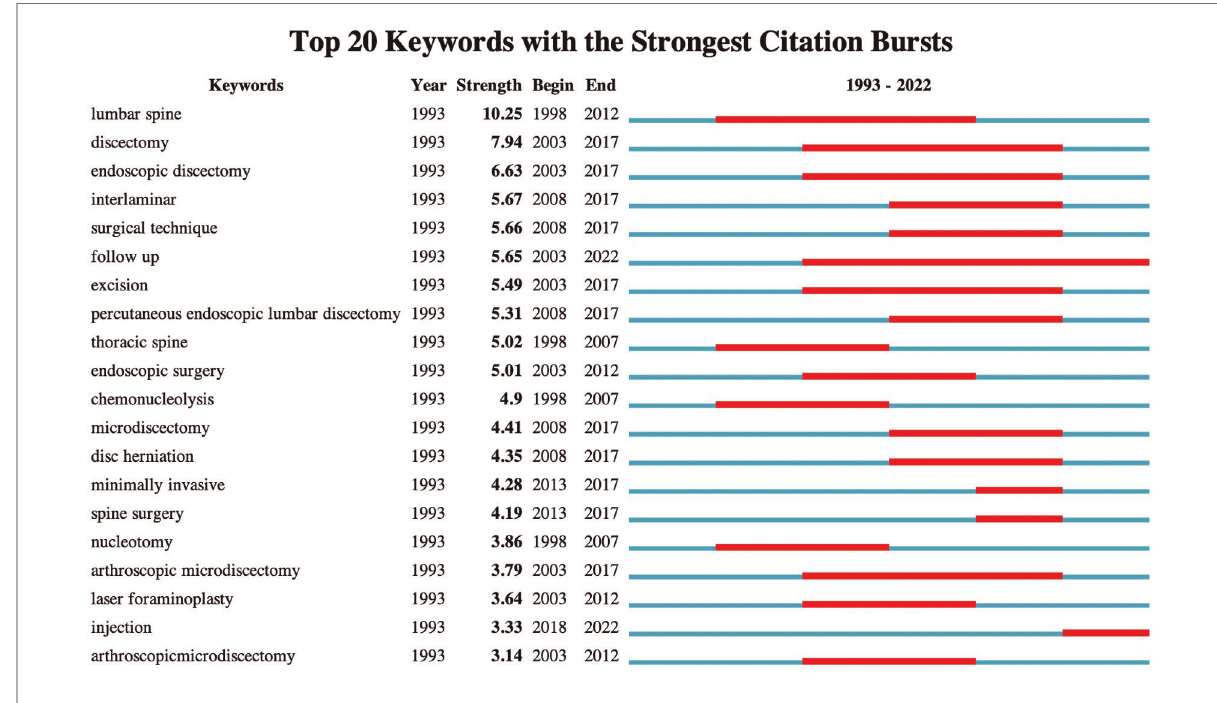
FIGURE 6 Top 20 keywords with the strongest citation